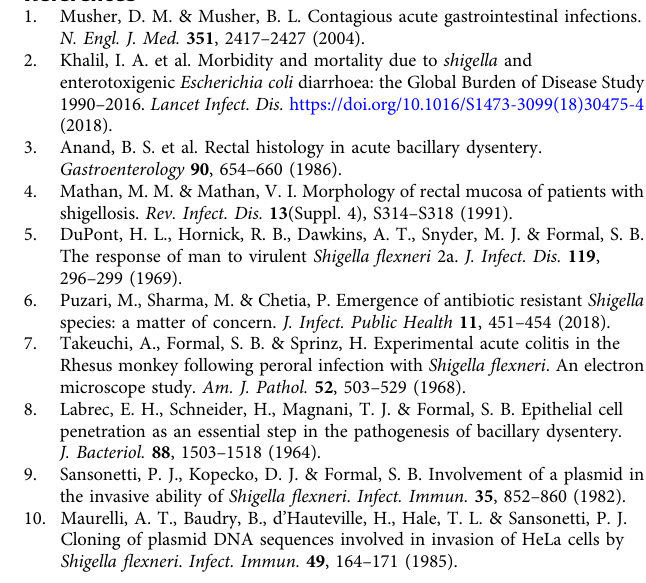
death (pale green) and be extruded from the epithelium. Fenestration of